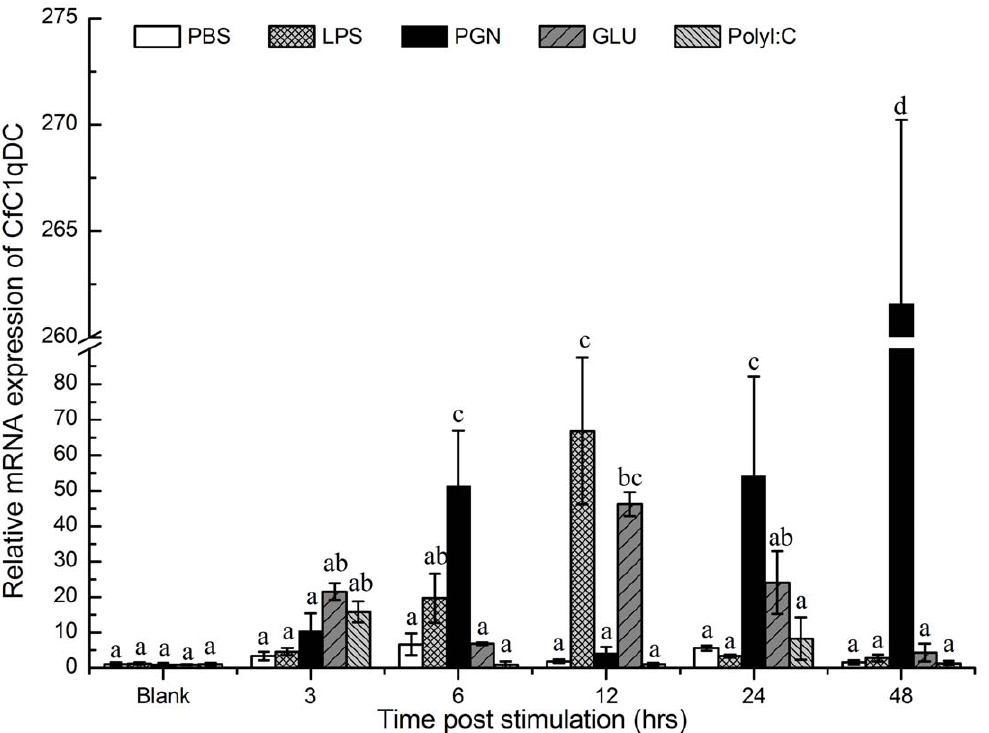
Figure 1. Temporal expression of the CfC1qDC transcripts in hemocytes after PAMPs challenge. Vertical bars represent the mean 6 S.E. (N=5).